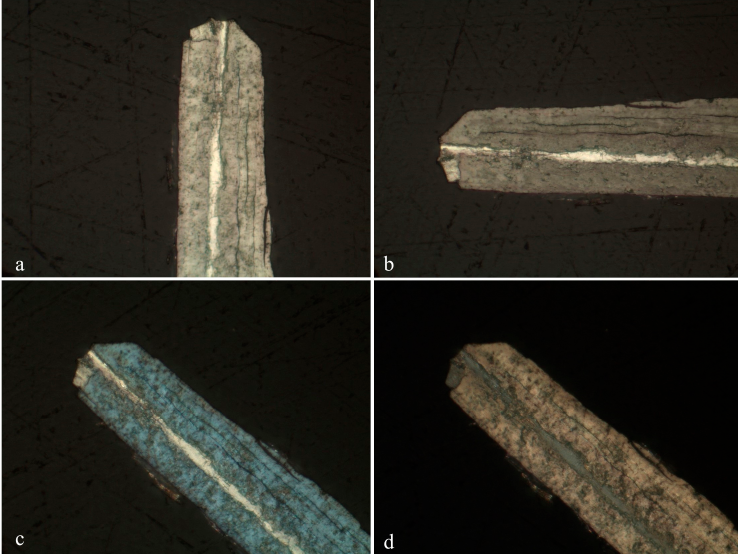
Figure 6. Reflected light microscope images of longitudinal sections of a polished merelaniite whisker (0.06 mm diameter) (Nikon Optiphot-Pol petrographic microscope): ( a ) Polarizer and analyzer both aligned vertically, parallel to the whisker axis; ( b ) Polarizer and analyzer both aligned vertically, perpendicular to the whisker axis; ( c , d ) Analyzer aligned vertically and polarizer slightly plus/minus un-crossed. It is not certain if the core of the whisker reflects more brightly due to a possible chemical difference between the core and outer region or is simply because the layers in the core are parallel to the polished surface. (A. E. Seaman Mineral Museum collection DM 31324, reference 3666ax2).